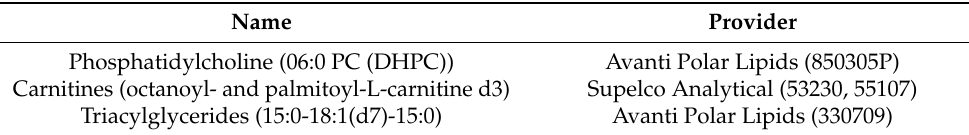
Table 1. Internal standards for analysis of different lipid species.